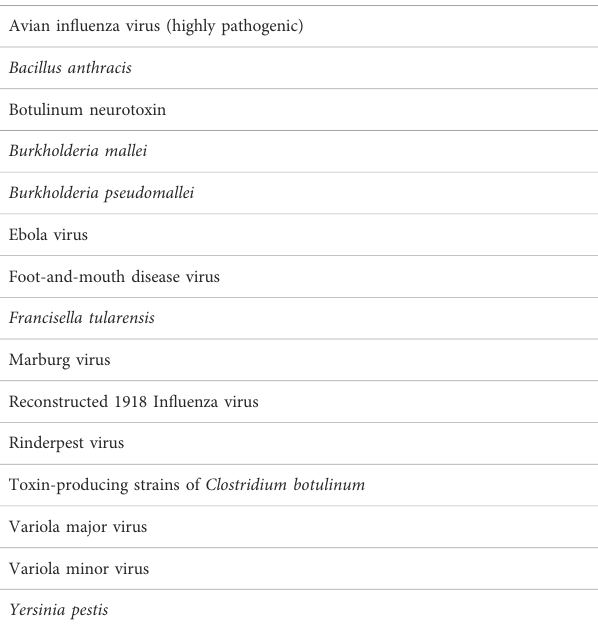
TABLE 1 Tier 1 pathogens of concern, federal select agent program.